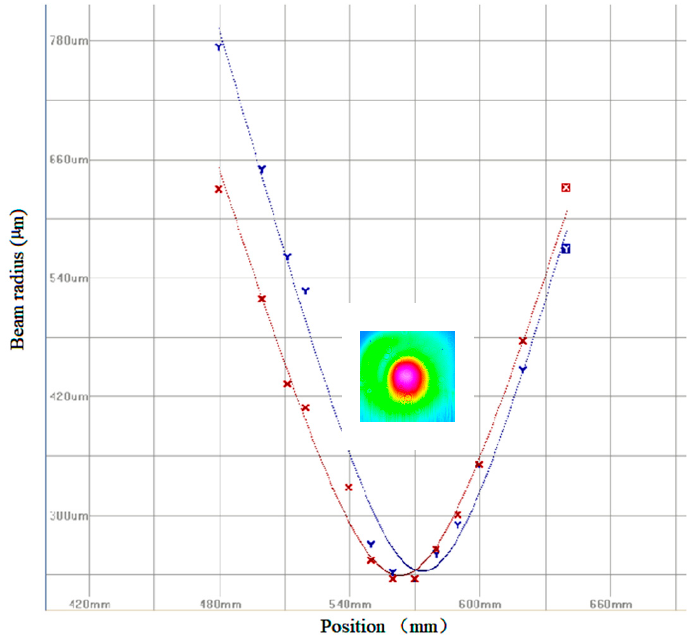
Figure 5. The M2 measurement at the maximum output power.